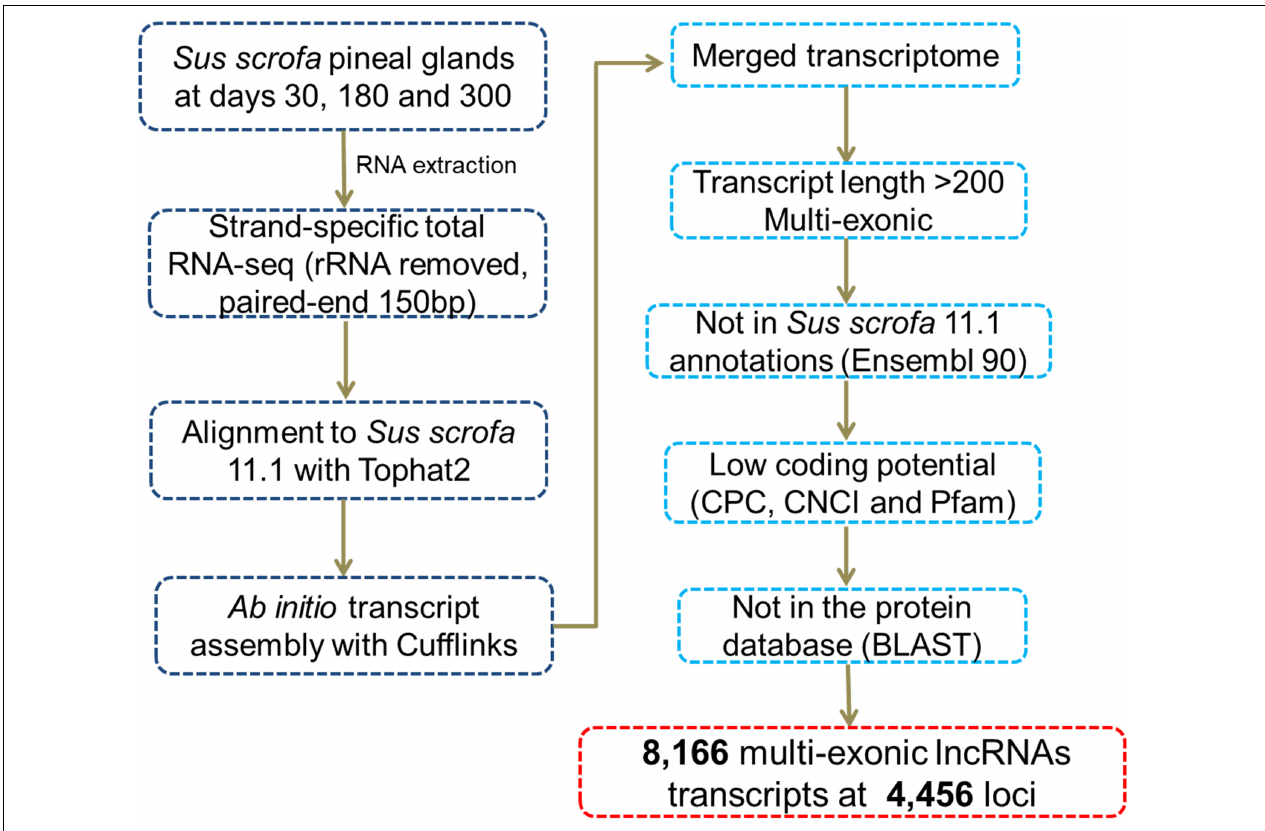
FIGURE 1 | Pipeline for the identification of novel